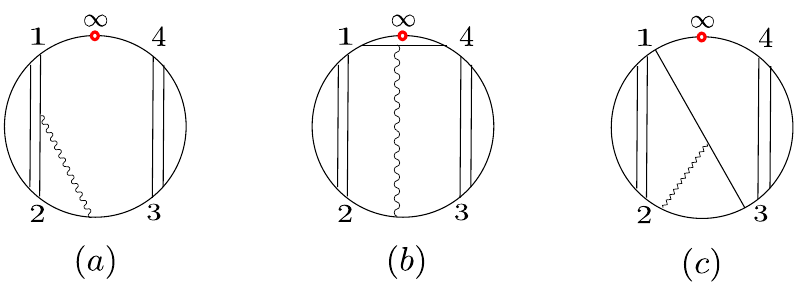
Figure 15 . Exmaples of the boundary diagrams at one loop. ( a ) A boundary diagram without diagonal contractions for ‘ 14 = ‘ 23 = 0. ( b ) A boundary diagram without diagonal contractions for ‘ 41 6 = 0. ( c ) A boundary diagram with diagonal